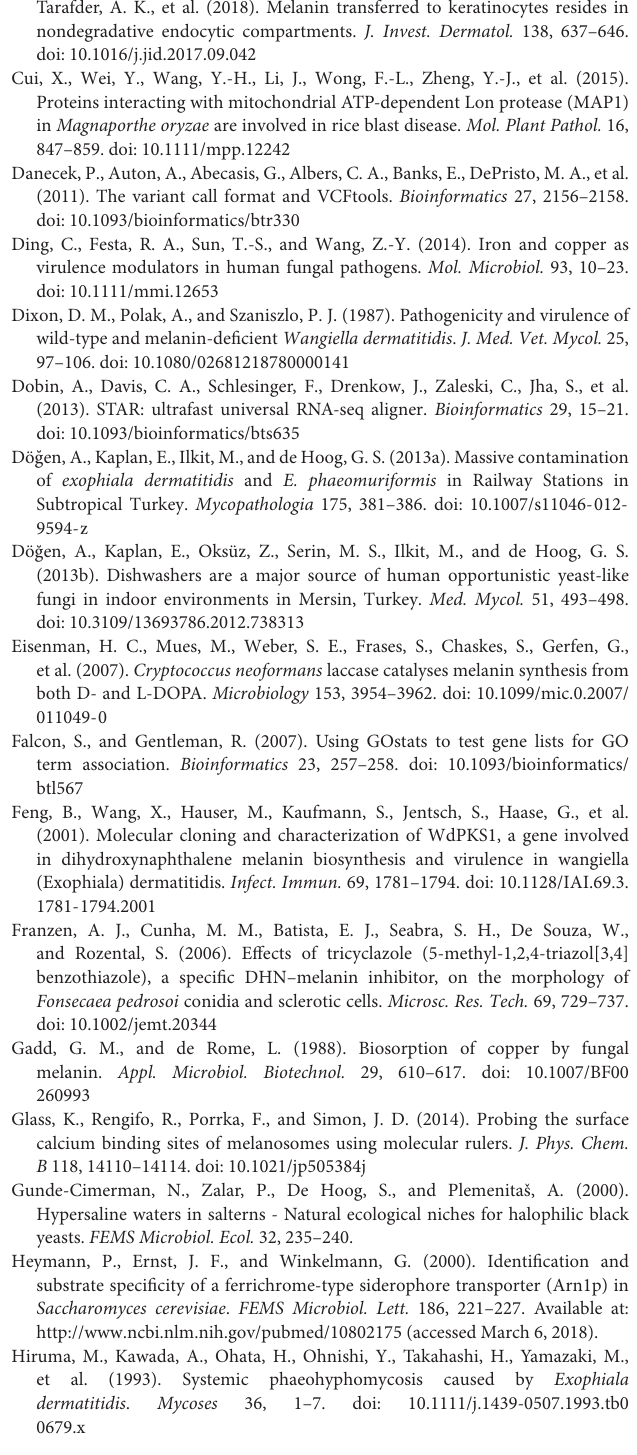
TABLE S1 | Table containing supplementary data on cell wall related genes, sgRNAs, mapping, featureCount, functional annotation, regulated virulence factors, putative expressed serine proteases, up and down regulated genes skin vs. controls, upregulated genes in WT vs. MT and dataset of enriched GO